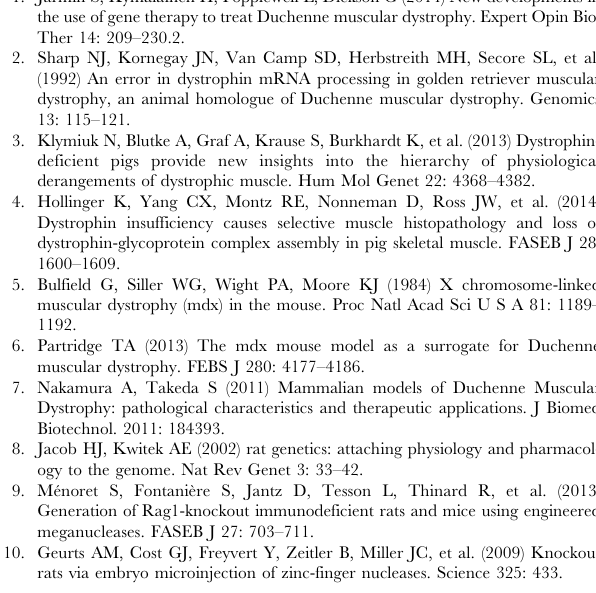
surrounded by some inflammatory cells ( # ), were associated with foci of small regenerative centro-nucleated fibers (arrow). Some muscle fibers were replaced by fibrotic (*) and fat (black